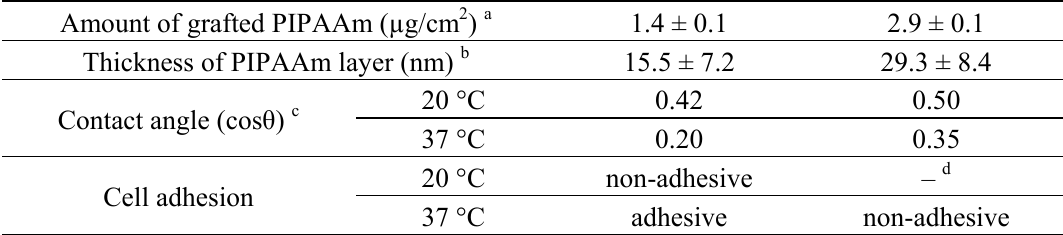
Table 1. Characterizations of poly( N -isopropylacrylamide) (PIPAAm) grafted surfaces. Amount of grafted PIPAAm (µg/cm 2 ) a